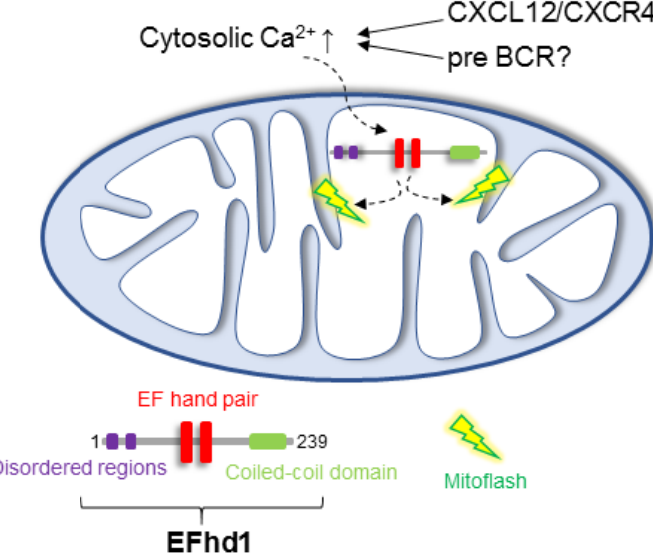
Figure 3. Putative mechanism for EFhd1-controlled mitoflashes in early B cells. Mitoflashes (also MitopHlashes) are bioenergetic responses to stochastic drops in the mitochondrial